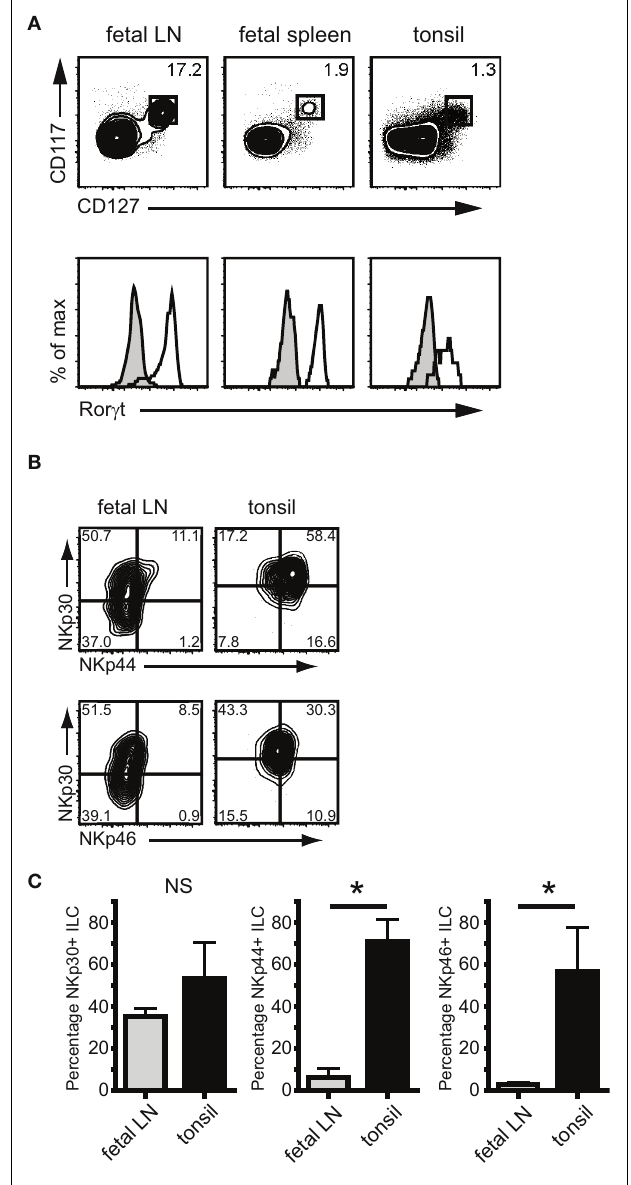
FIGURE 1 | NCR expression on ILC from fetal LN and tonsil. (A) Lineage-negative cells in fetal lymph nodes, fetal spleen, and tonsil labeled for CD117 and CD127 are RORC positive. Shaded histogram indicates isotype control staining (representative example of three independent experiments). (B) Flow cytometric analysis of NKp30 ( p = 0.07), NKp44 ( p = 0.00), and NKp46 ( p = 0.03) expression on ILC and fetal lymph nodes and tonsil. (C) Percentage of NKp30, NKp44, and NKp46 expressing RORC + ILC in fetal lymph nodes and tonsil ( n > 5; average ±